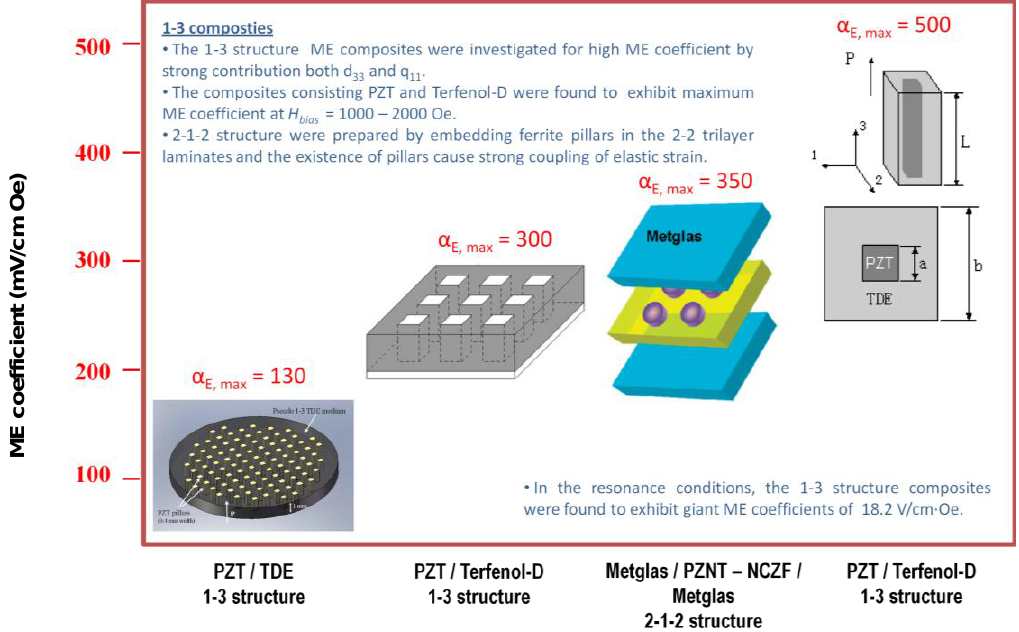
Figure 24. Magnetoelectric coefficient for 1-3 composites in off-resonance